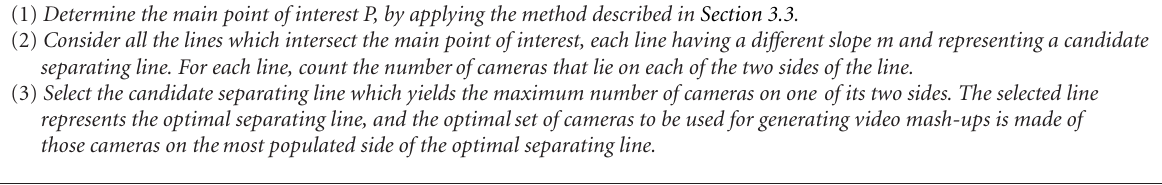
Algorithm 3: Selection of optimal cameras.